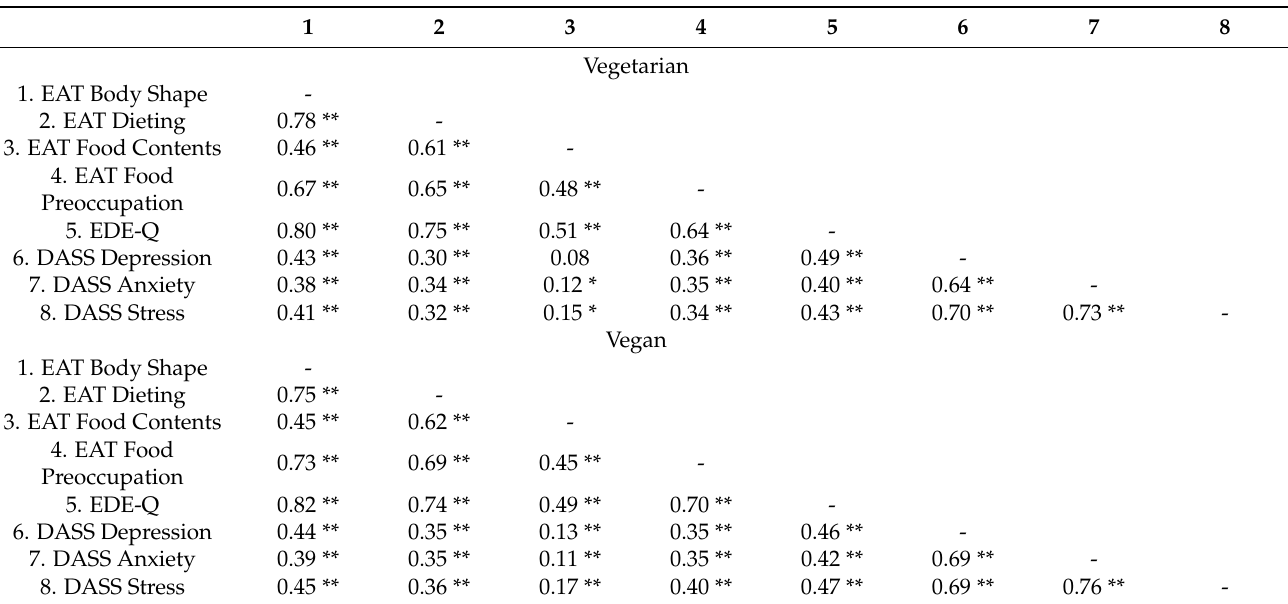
Table 5. Convergent and discriminant validity of Ocker et al.’s [9] 16-item four-factor model of the Eating Attitudes Test in vegetarians, vegans, and